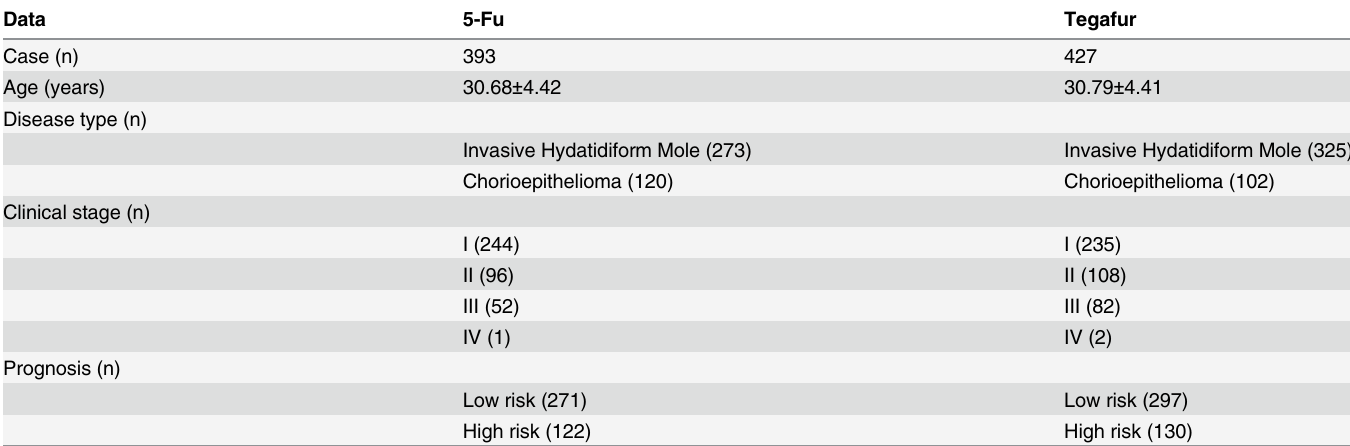
Table 1. General data.